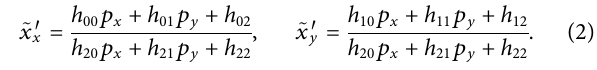
Frontiers in Virtual Reality |